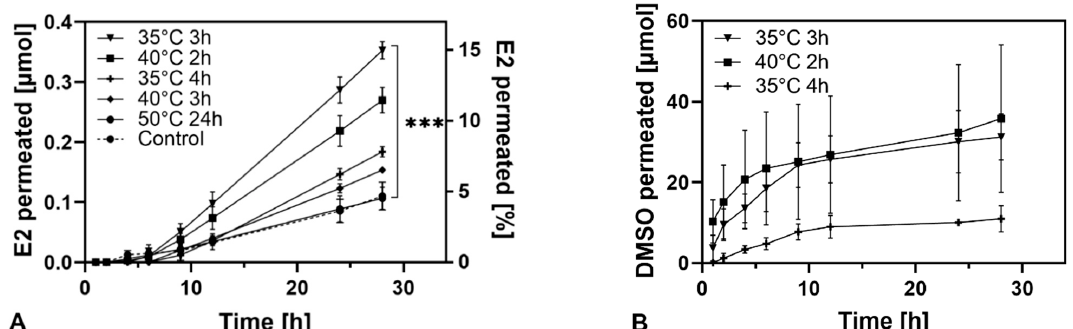
Figure 4. Permeation profiles of E2 ( A ) and DMSO ( B ) across pig skin at 32 °C. Percental permeated amount of DMSO: 35 °C, 4 h: 11.5 ± 0.7; 40 °C, 2 h: 21.8 ± 1.9; 35 °C, 3 h: 65.4 ± 3.1 (mean ± SD). *** Indicates significant differences ( p < 0.001).